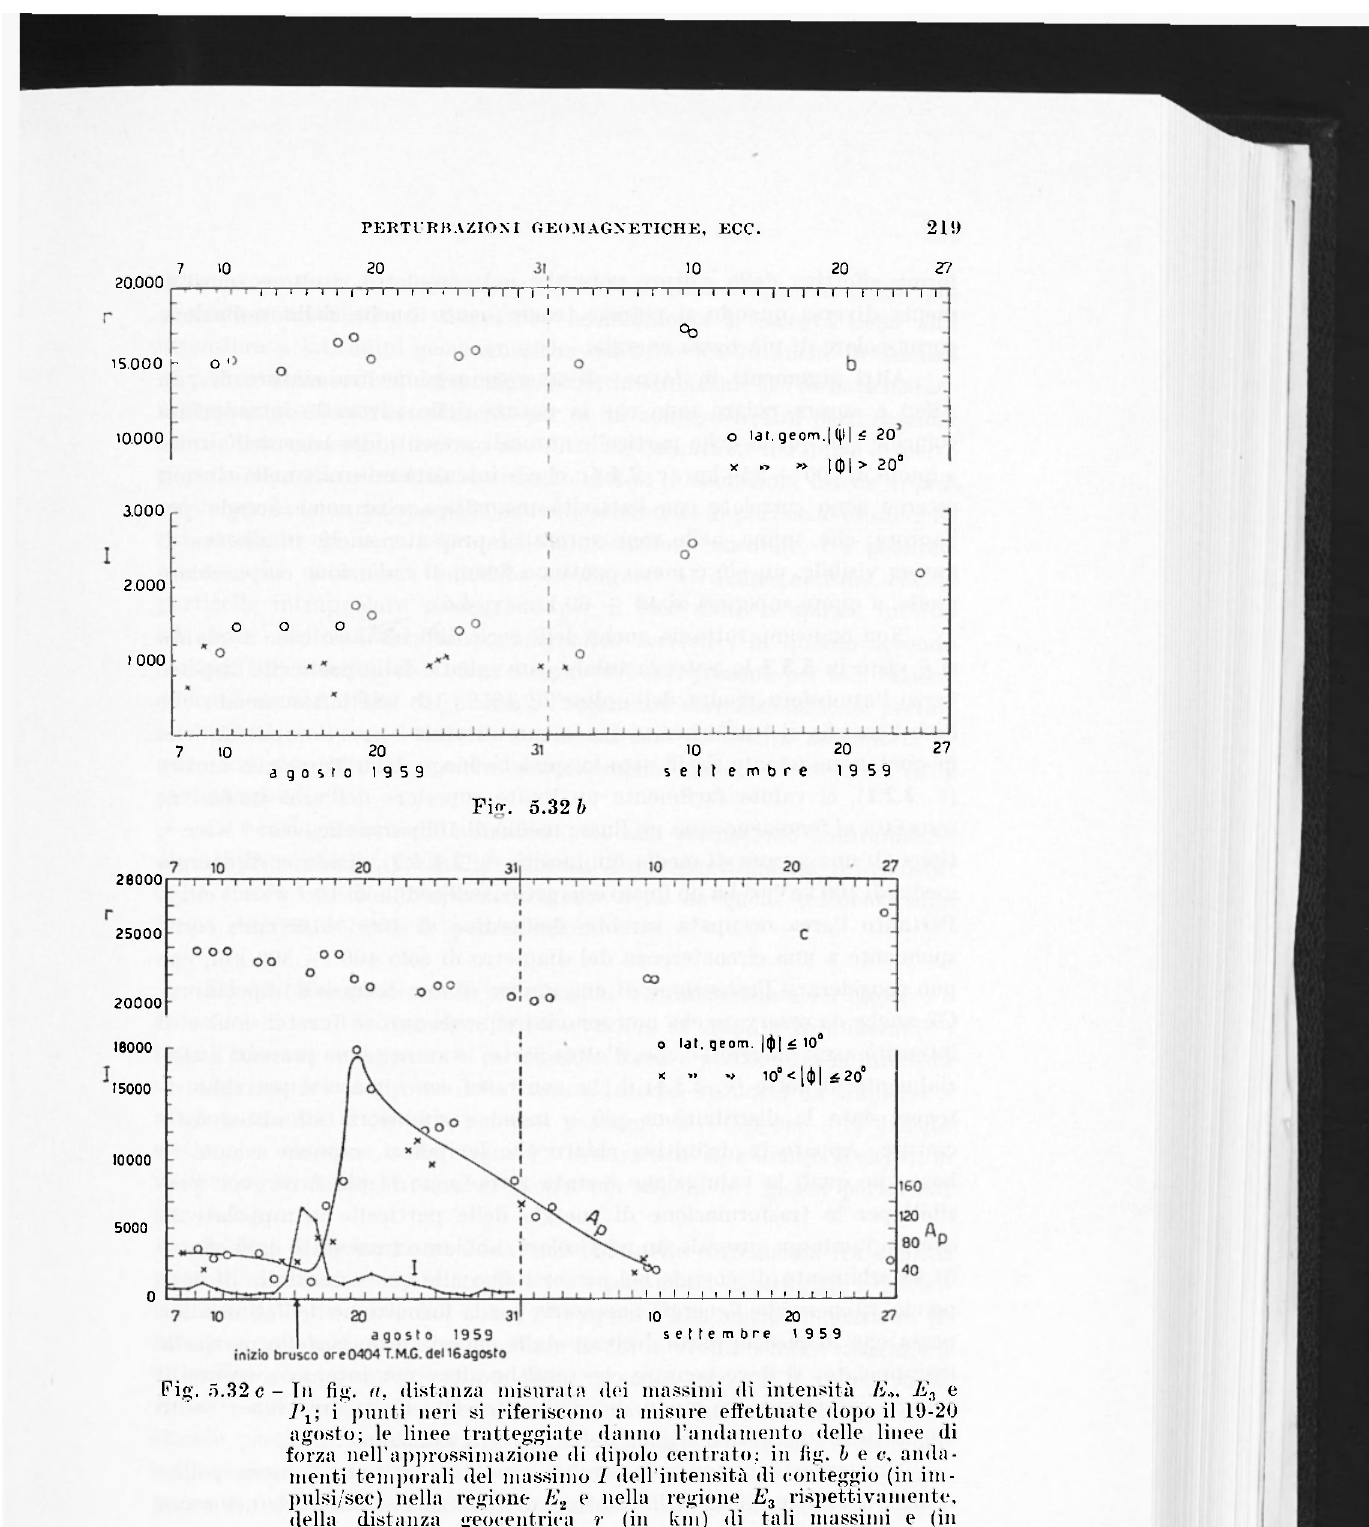
Fig. 5.32 c - In fig. a, distanza misurata dei massimi di intensità E.,, E 3 e P x ; i punti neri si riferiscono a misure effettuate dopo il 19-20 agosto; le linee tratteggiate danno l'andamento delle linee di forza nell'approssimazione di dipolo centrato; in fig. b e e, anda- menti temporali del massimo 1 dell'intensità di conteggio (in im- pulsi/sec) nella regione E 2 e nella regione E 3 rispettivamente, della distanza geocentrica r (in km) di tali massimi e (in fig. c) dell'indice magnetico A p (secondo Fan, Meyer e